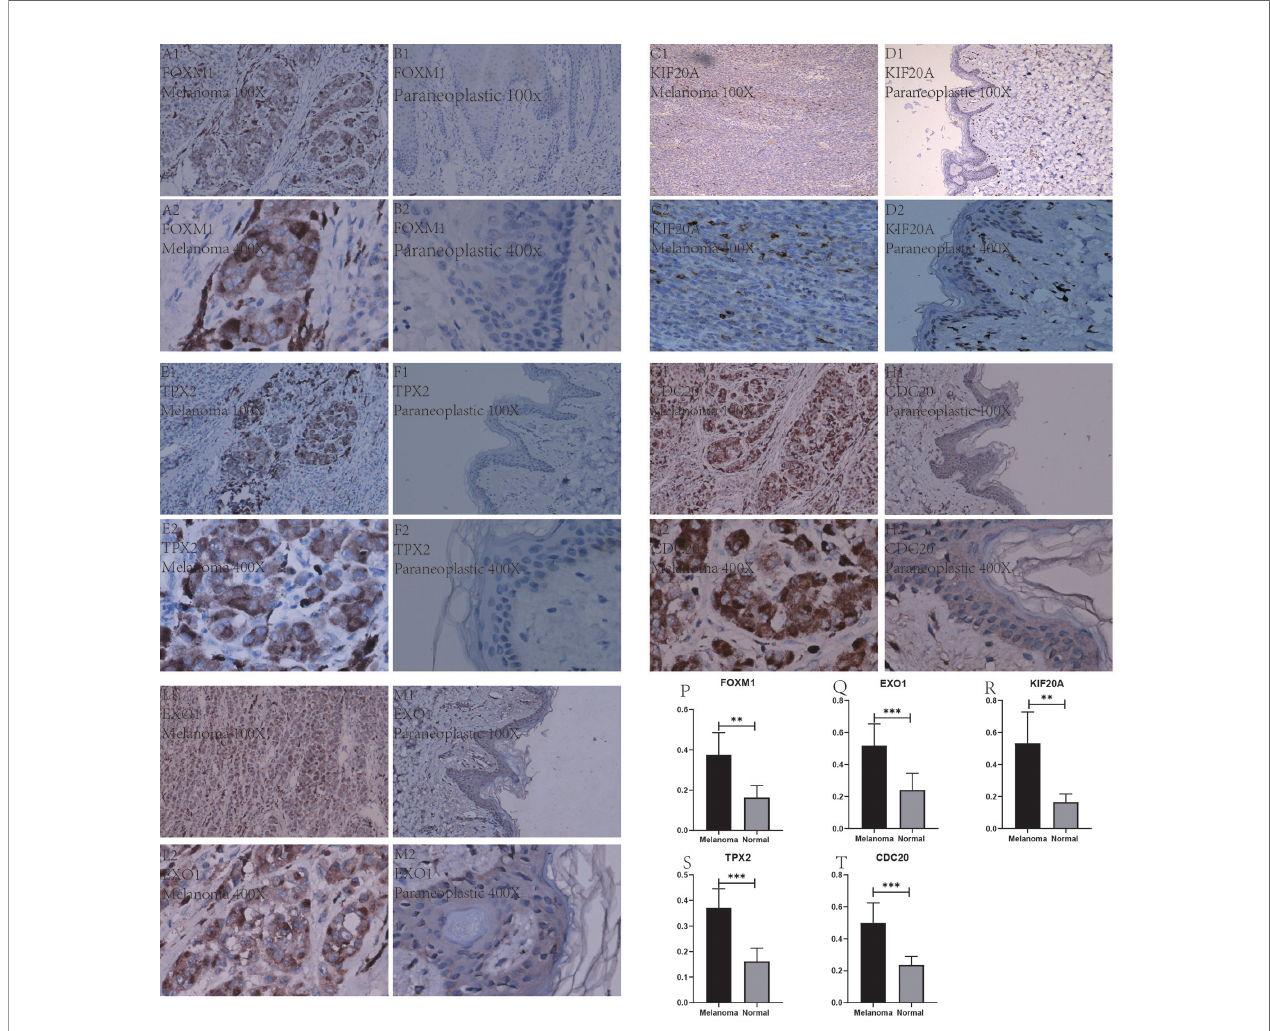
FIGURE 11 | Immunohistochemical plots of the fi ve Hub genes associated with prognosis and statistical analysis of the positivity rate. (A1 – M2) show the protein expression of each gene in melanoma and in the paracancerous tissue. (P – T) shows the statistical analysis of the staining positivity rate for each gene in melanoma and in the paracancerous tissue. **representative P-value < 0.01, ***representative P-value <